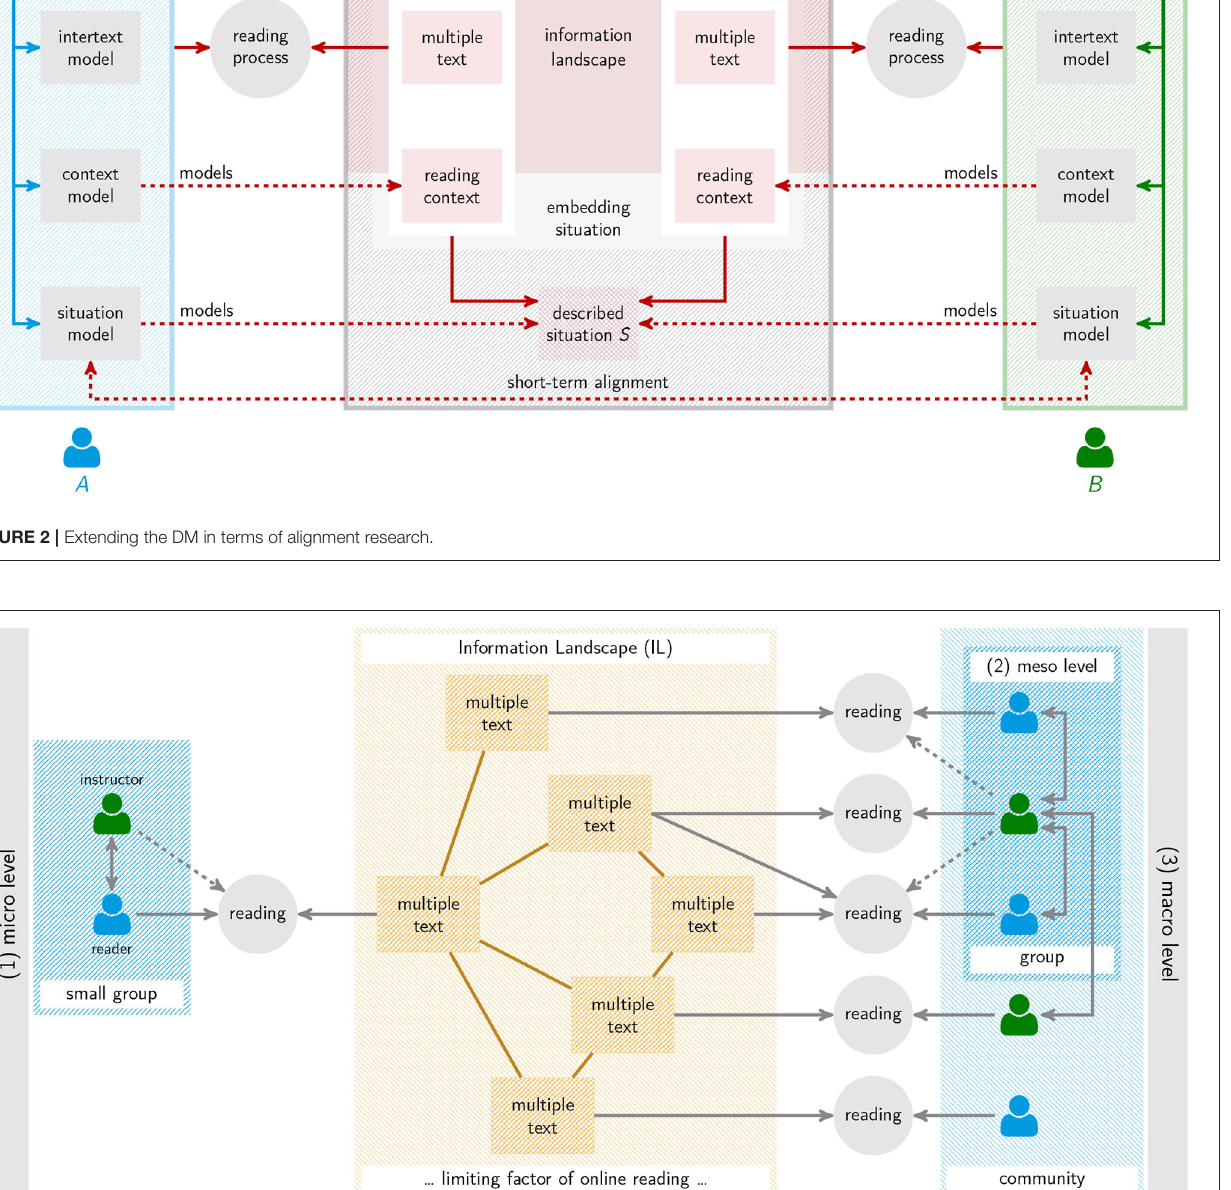
Frontiers in Education |